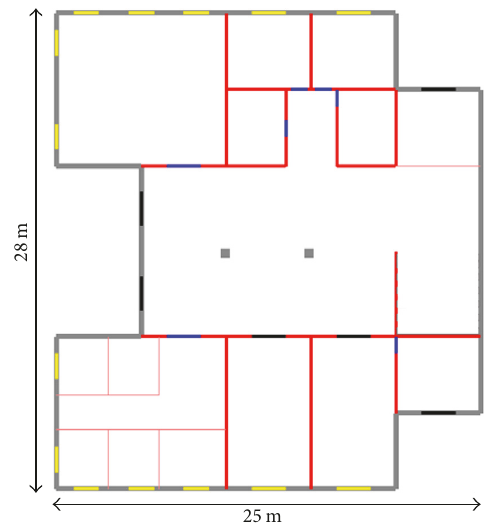
Figure 2: 2D construction plan of the first floor of the north wing of the building.